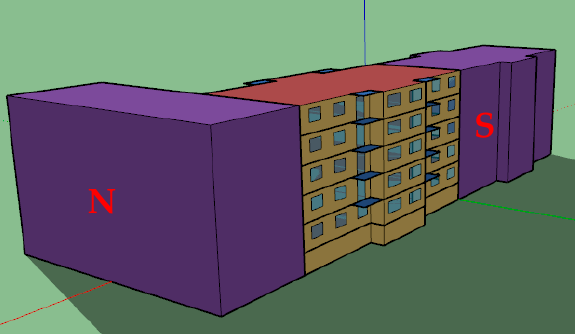
Figure 4. Geometry model of the building realised in SketchUp.